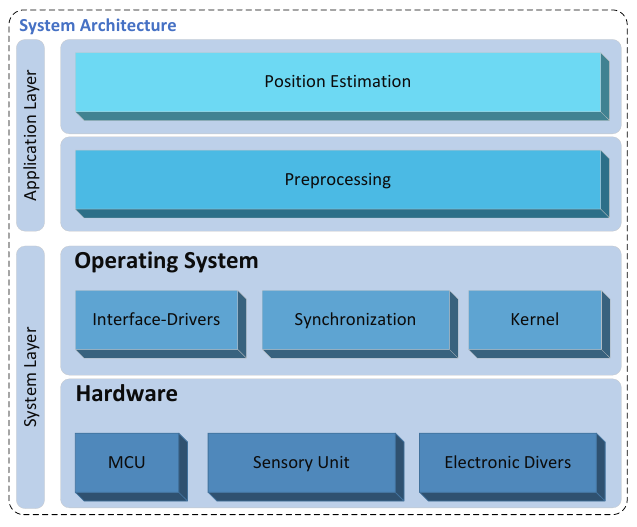
Figure 4. The architecture of the mobile